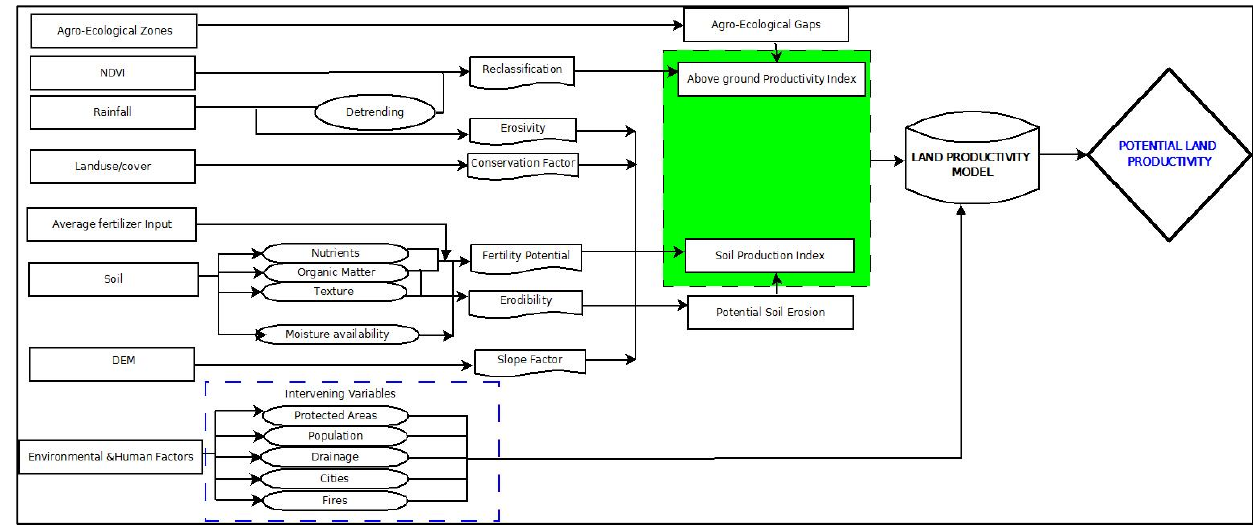
Figure 2. Land productivity